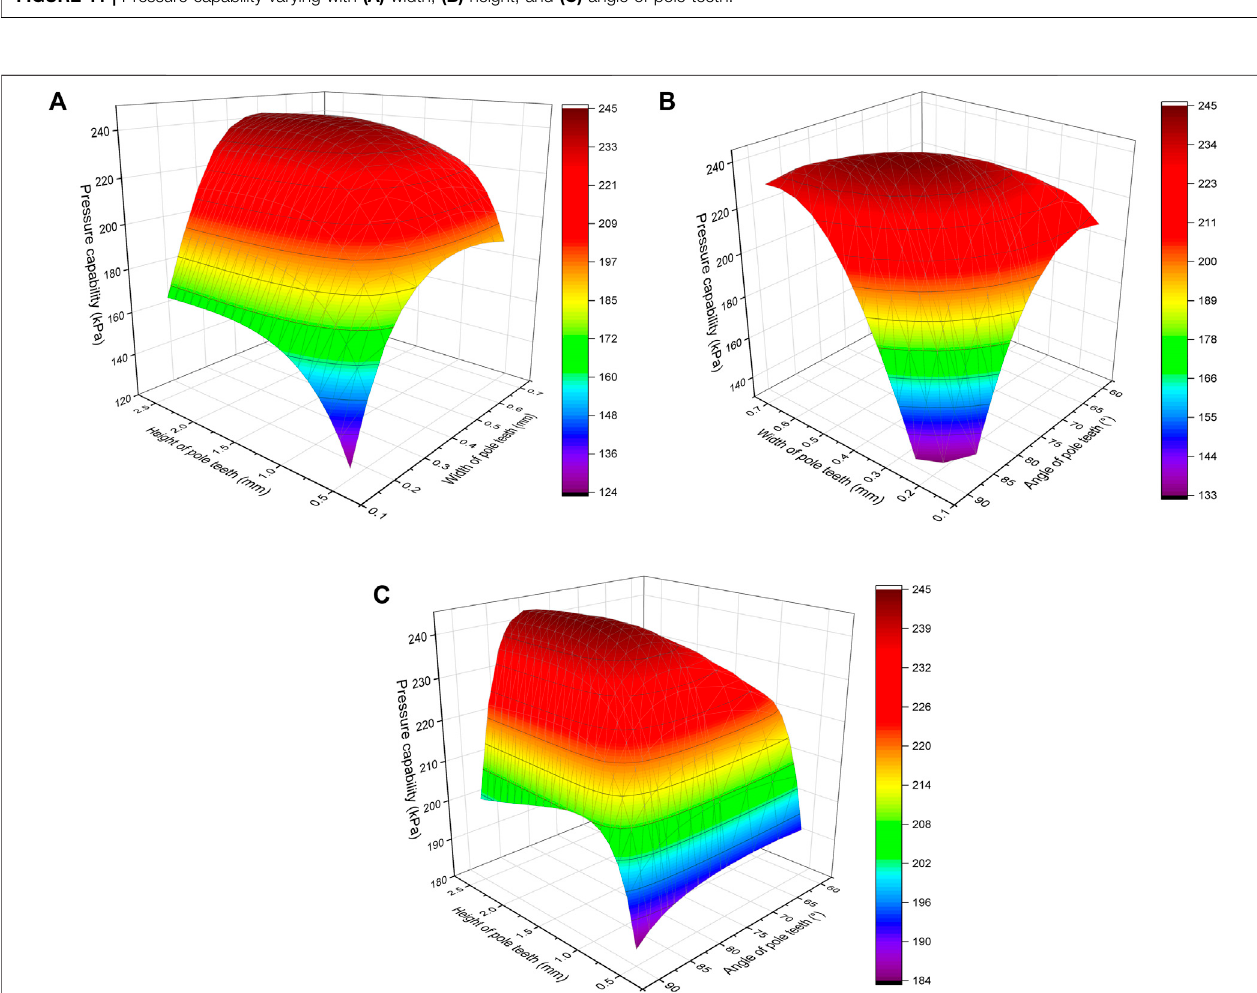
FIGURE 12 | Joint in fl uence on pressure capability by (A) width and height, (B) width and angle, and (C) height and angle.